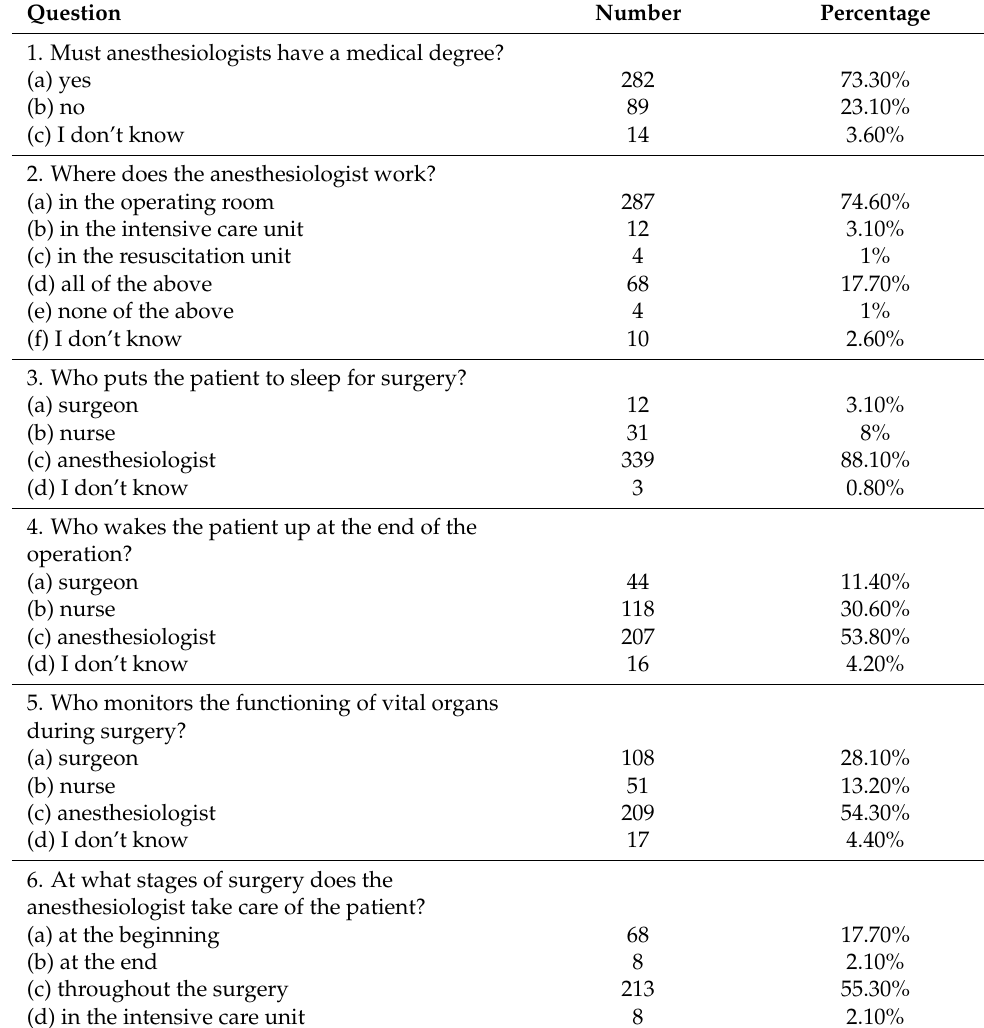
Table 3. Patients’ knowledge of anesthesia and perceptions of anesthesiologists’